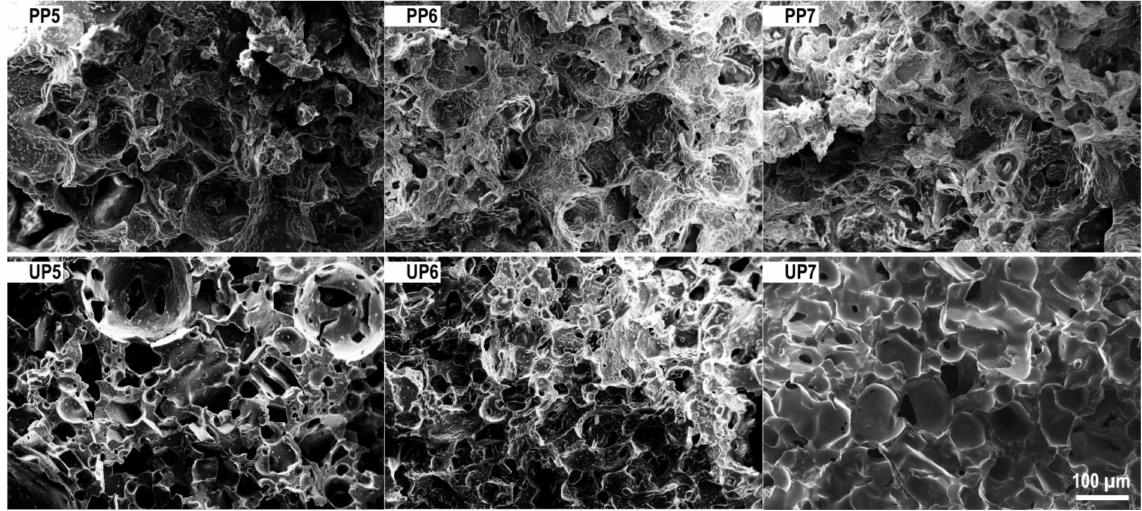
Figure 3. Ice cream structure by scanning electron microscopy. Ice cream samples were pictured with a secondary electron detector at 3 kV on a 100 m scale. PP5—sample with 5% tomato seed oleogel, traditionally pasteurized; PP6—sample with 6% tomato seed oleogel subjected to traditional pasteurization; PP7—sample with 7% tomato seed oleogel subjected to traditional pasteurization; UP5—sample with 5% tomato seed oleogel subjected to ultrasound pasteurization; UP6—a sample with 6% tomato seed oleogel subjected to ultrasound pasteurization; UP7—sample with 7% tomato seed oleogel subjected to ultrasound